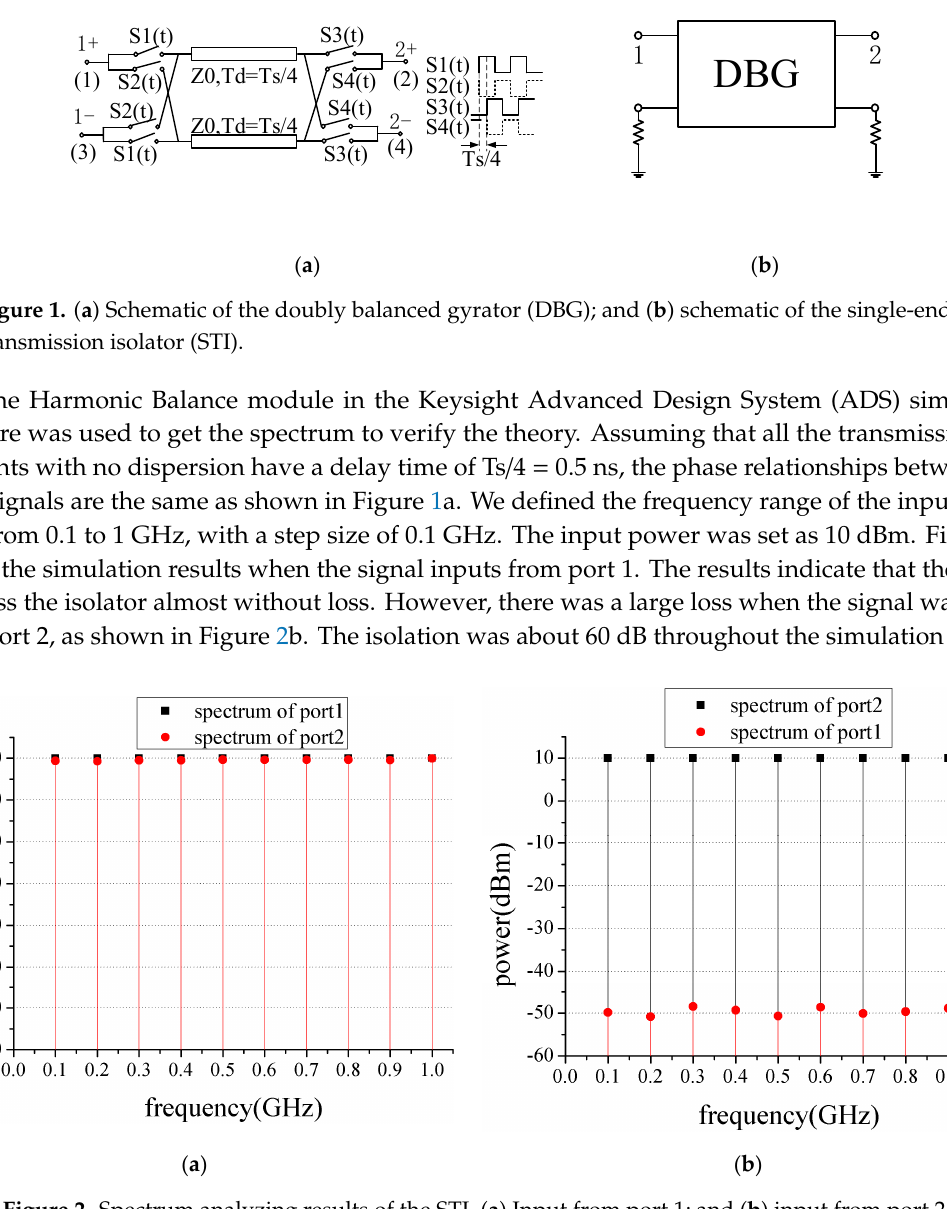
Figure 1. ( a ) Schematic of the doubly balanced gyrator (DBG); and ( b ) schematic of the single-ended transmission isolator (STI).